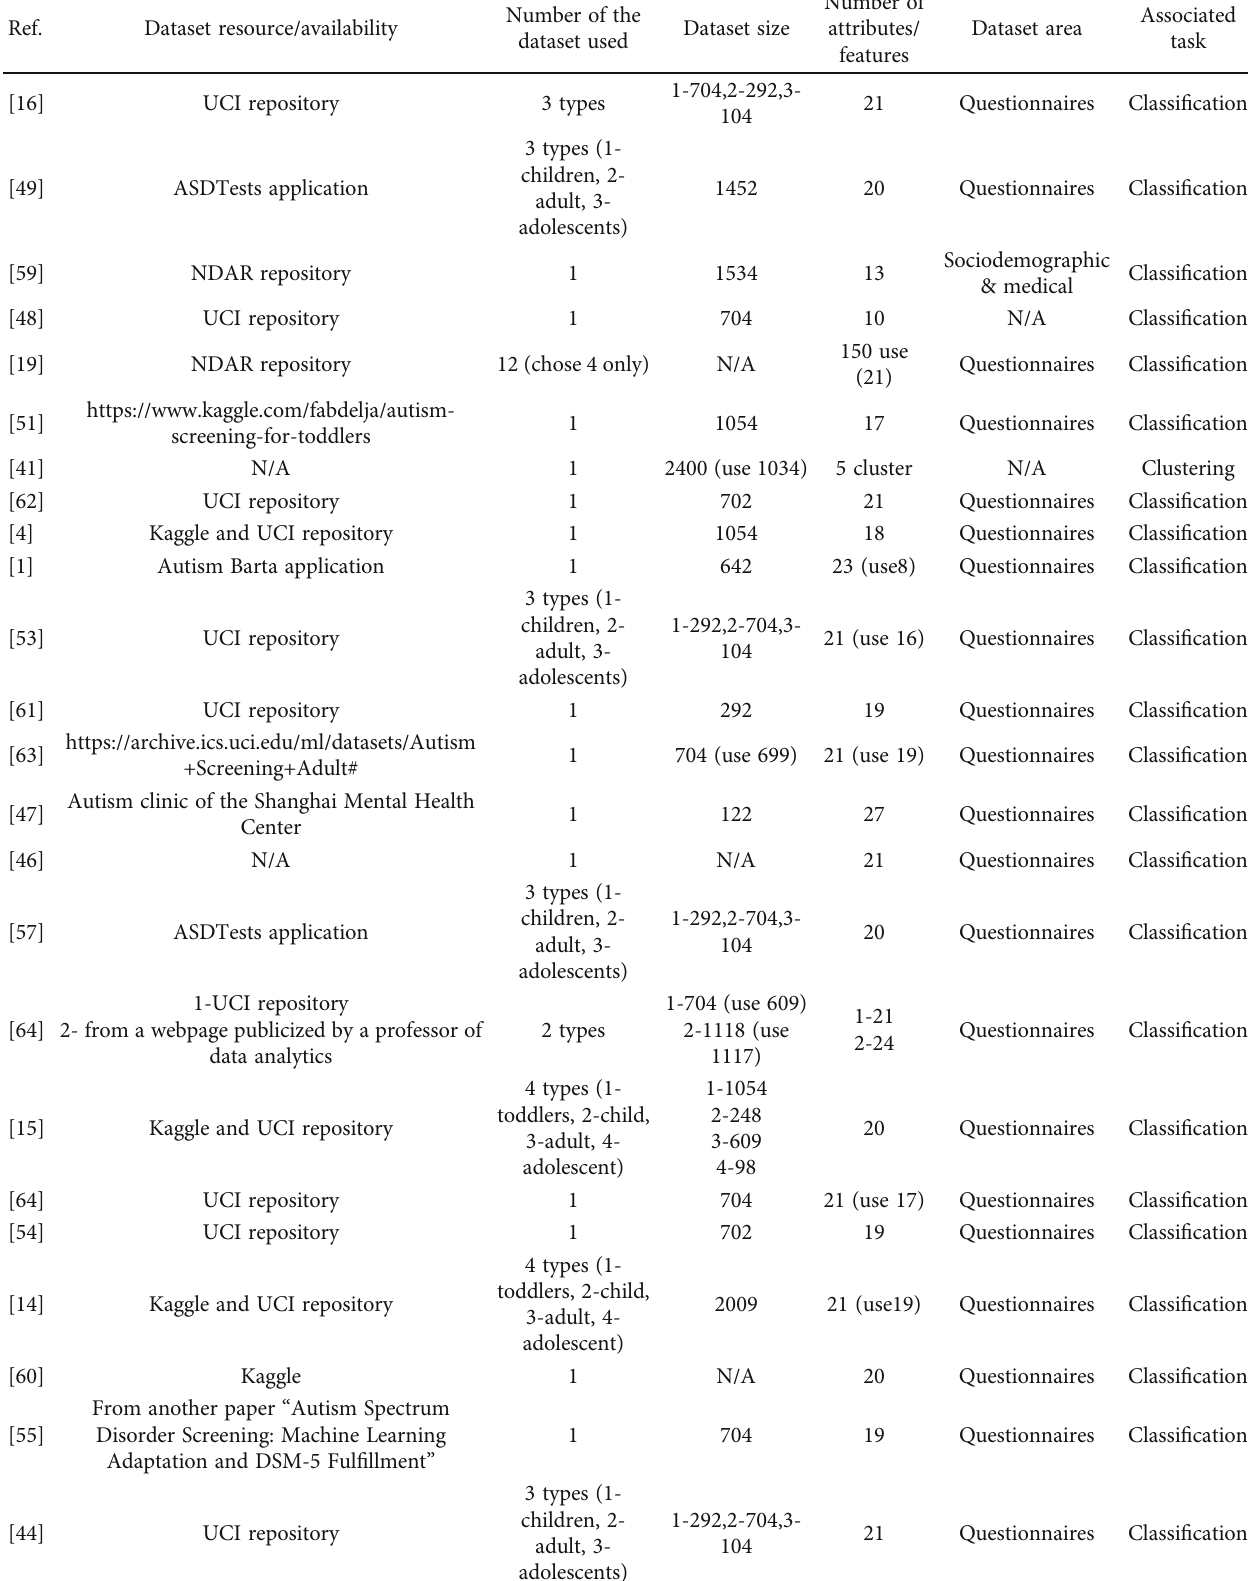
Table 1: Description dataset used and information extraction from systematic literature review.